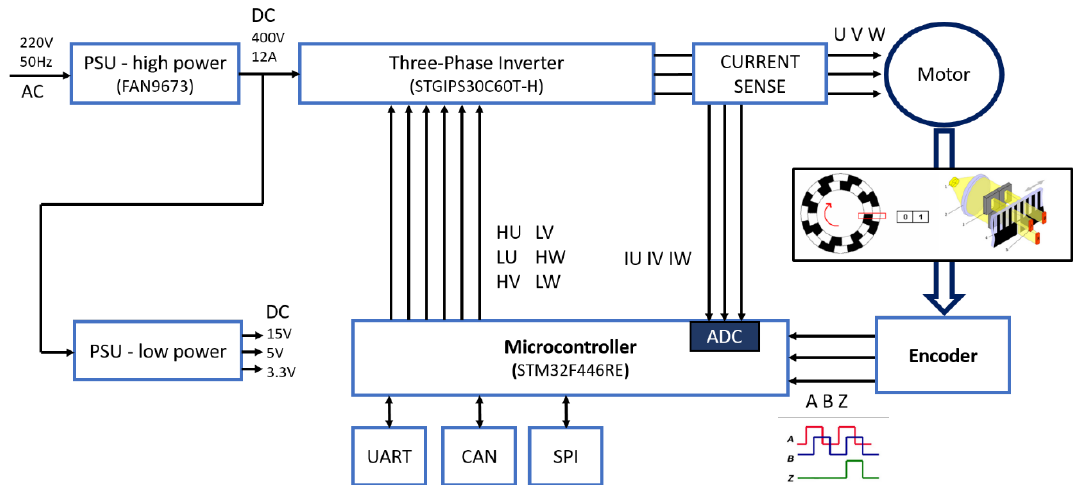
Figure 3. Block diagram of the whole electrical/electronic (E/E) system.